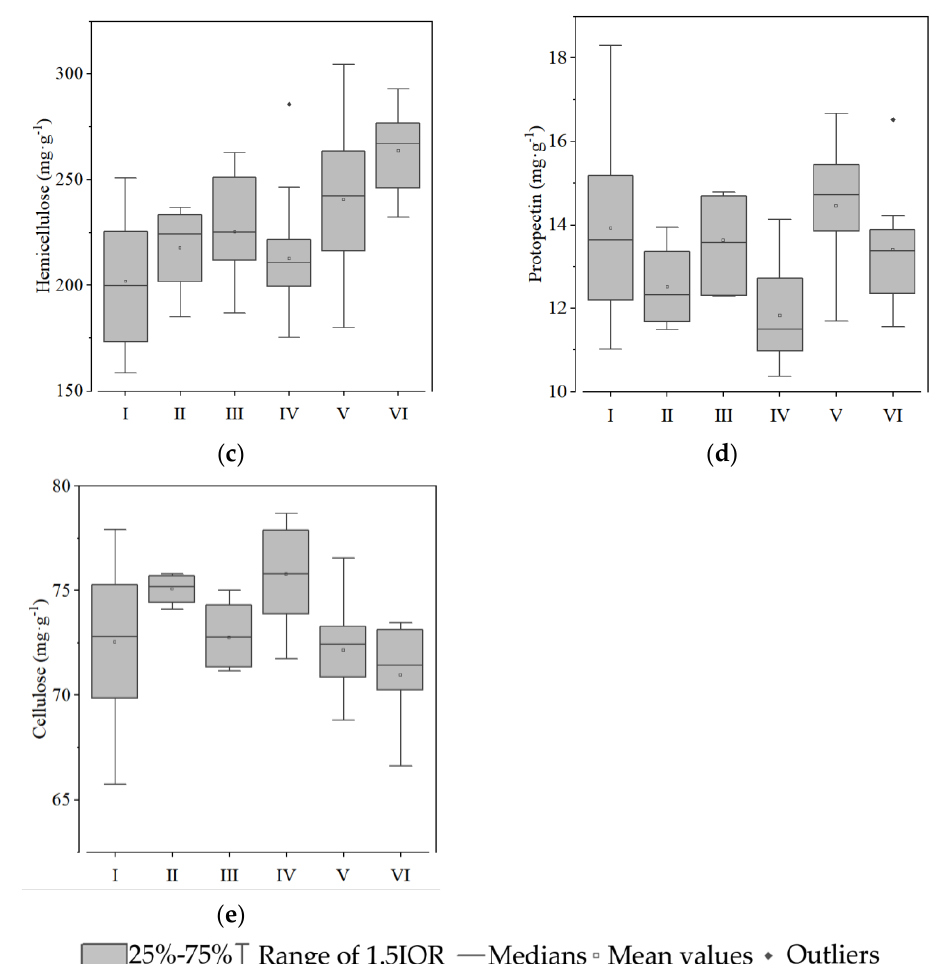
Figure 5. Cell wall components of the tuberous roots of six groups of sweet potato: ( a ) lignin; ( b ) soluble pectin; ( c ) hemicellulose; ( d ) protopectin; and ( e ) cellulose. White squares indicate mean values. Rhombuses indicate outliers.